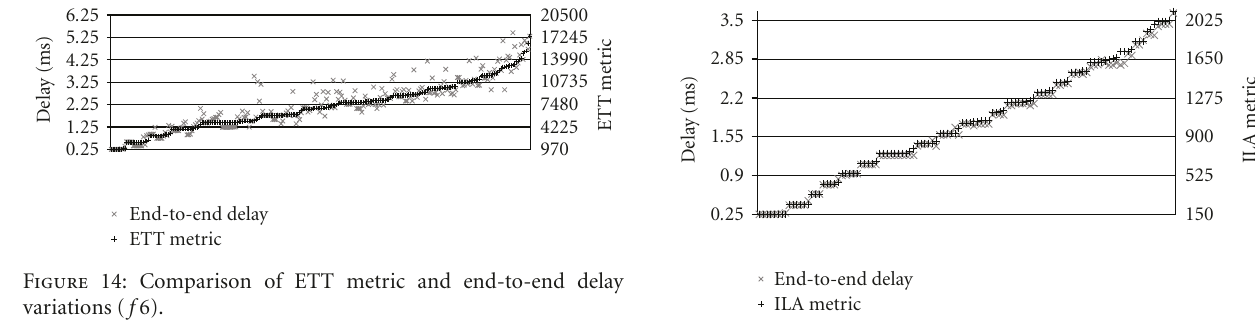
Figure 16: ILA regions: (a) Routes under no interference.